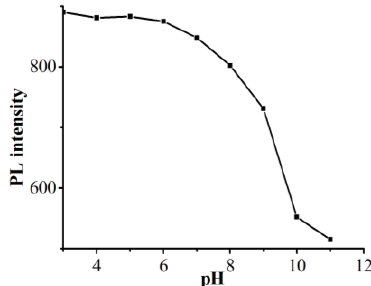
Figure 10. Fluorescence intensity of CDs/PNIPAM at different pH conditions.